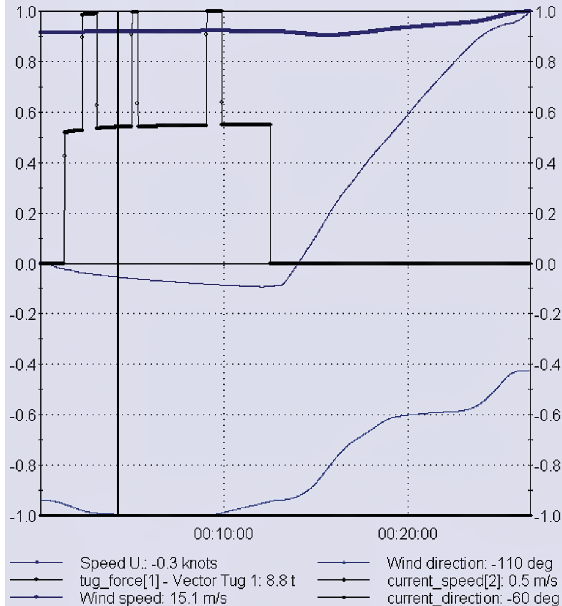
Fig. 9. PANAMAX tanker, tug movement and environmental parameters considering position details presented in Fig.